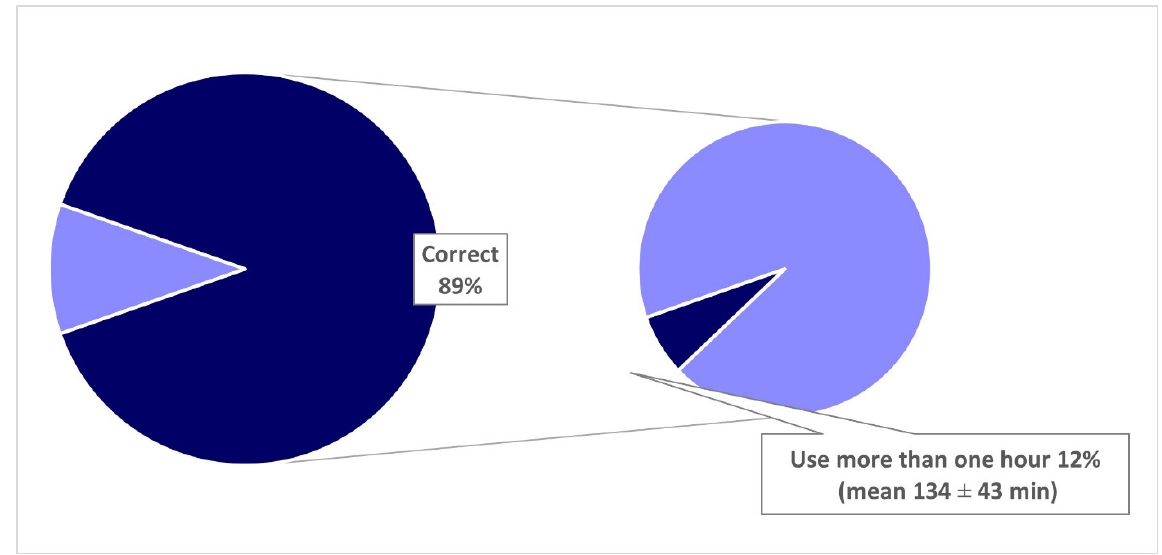
Figure 4. Comparison between opinions about the correct time of use by children aged 3–5 years and responses about the actual use (Correct = one hour maximum) [21]. Analyses limited to parents having only children aged 3–5 years or both children aged 0–2 and 3–5 years.